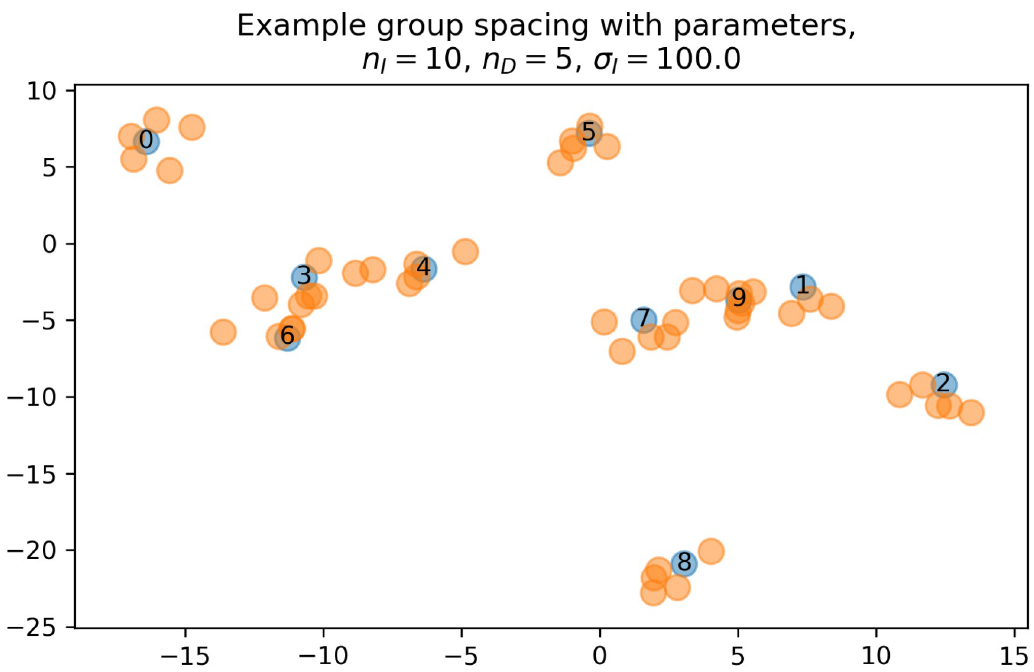
, n , σ , σ (the two top layers). The “single-file I D I D for k 2 k